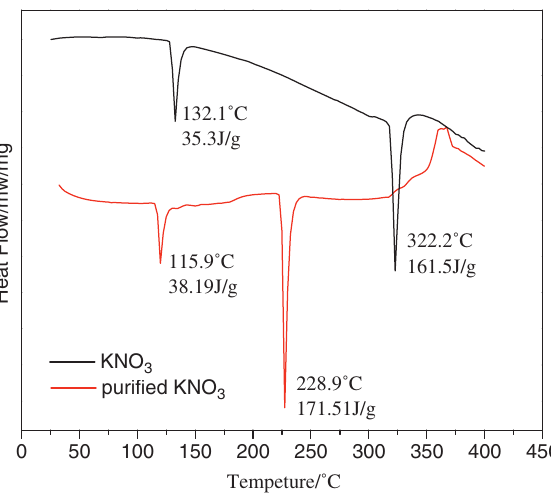
Figure 8: DSC curves of potassium nitrate molten salt and purified potassium nitrate molten salt.